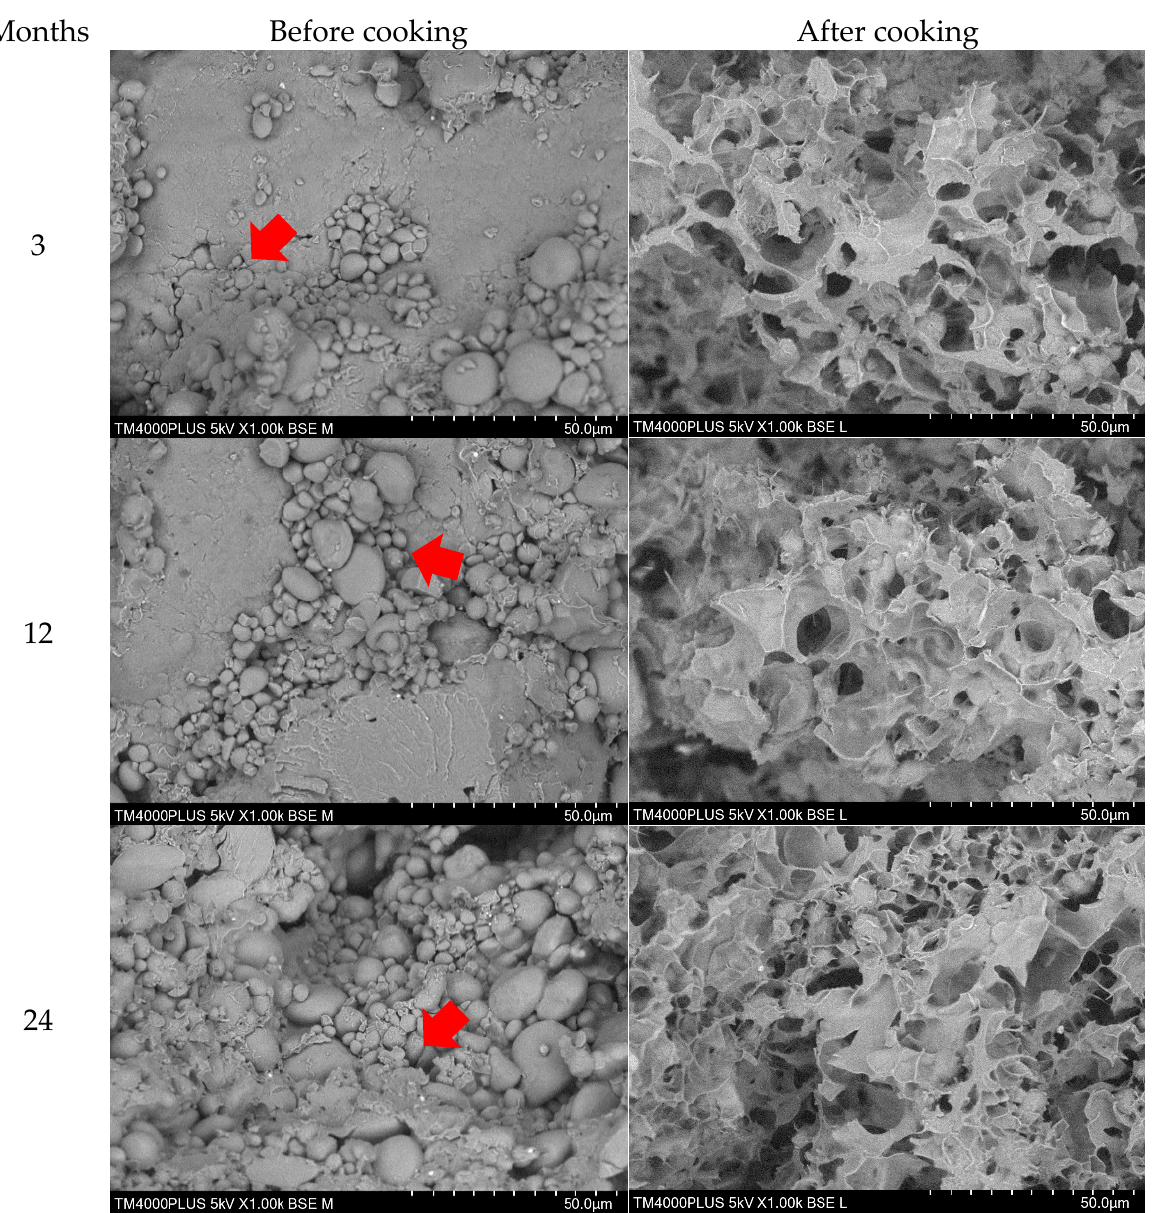
Figure 6. SEM of wheat noodles fortified with isomaltodextrin during different storage periods at − 20 °C.